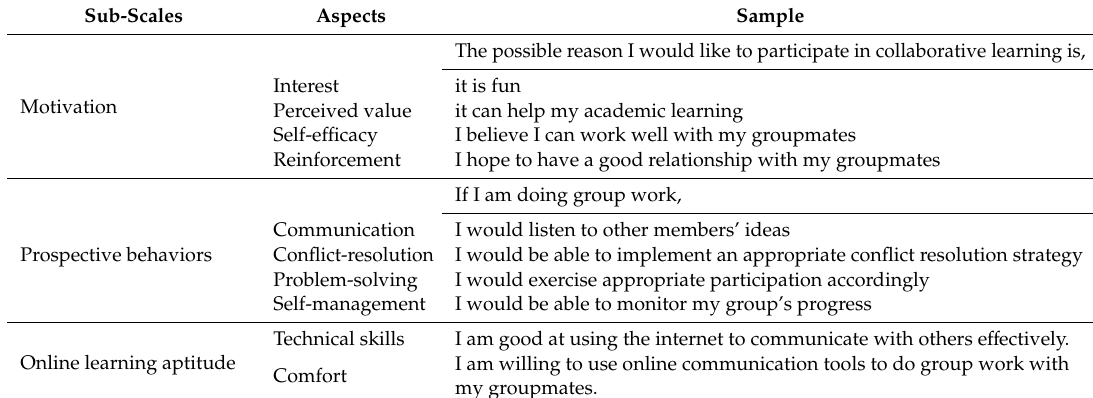
Table 1. Students’ readiness for CSCL instrument adopted from Xiong et al. [21].